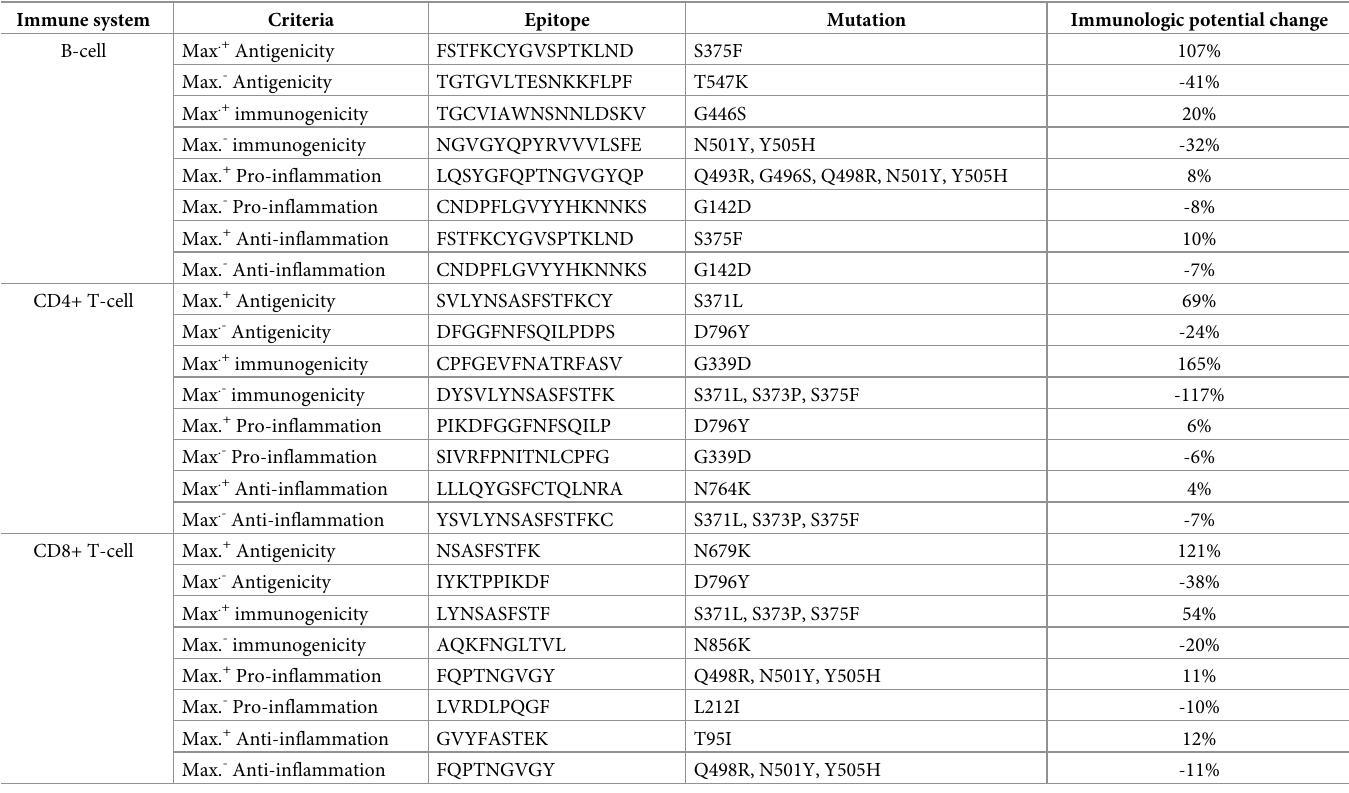
Table 4. Epitopes with maximum increased or decreased immunologic potentials due to mutations. Several of the mutations are in the RBD region. Immune system